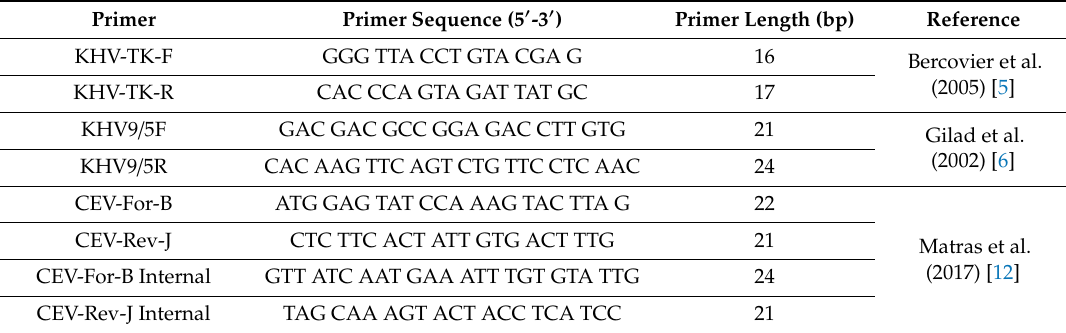
Table 1. List of oligonucleotide primer use in this